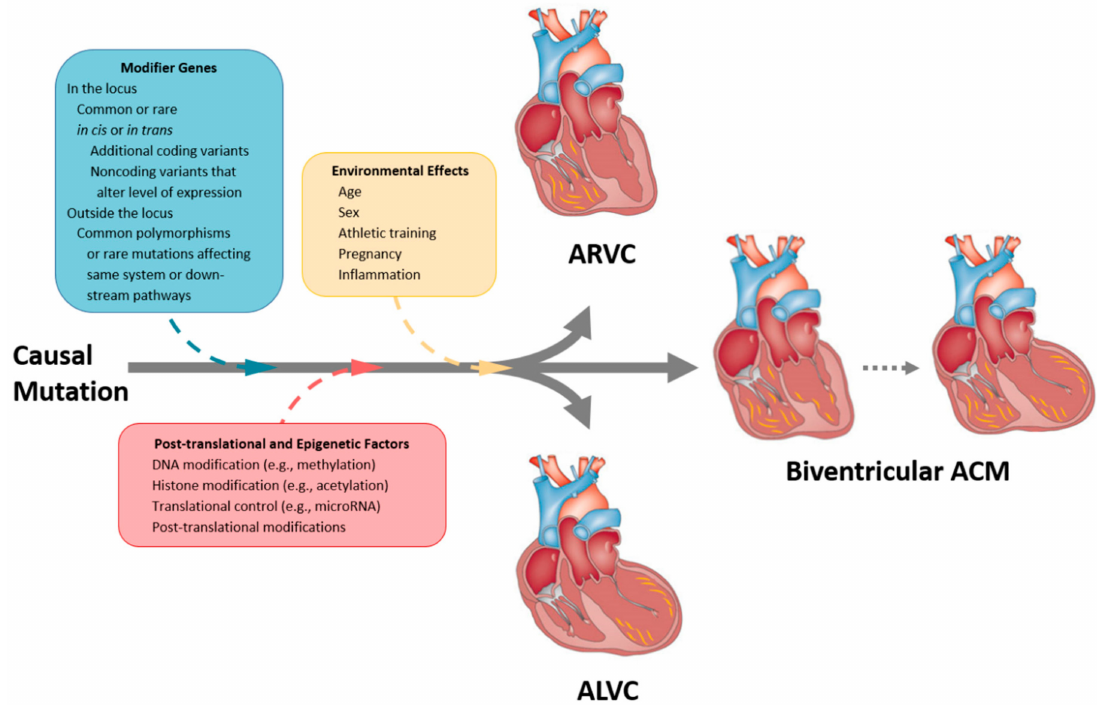
Figure 21. Schematic view of the possible modifier genes, post-translational, epigenetic, and environmental factors contributing to the pathogenesis of ACM including ARVC, ALVC, and biventricular ACM. ModifiedfromWatkinsetal. (2011)[131]. ACM = arrhythmogeniccardiomyopathy; ALVC = arrhythmogenic left ventricular cardiomyopathy ARVC = arrhythmogenic right ventricular